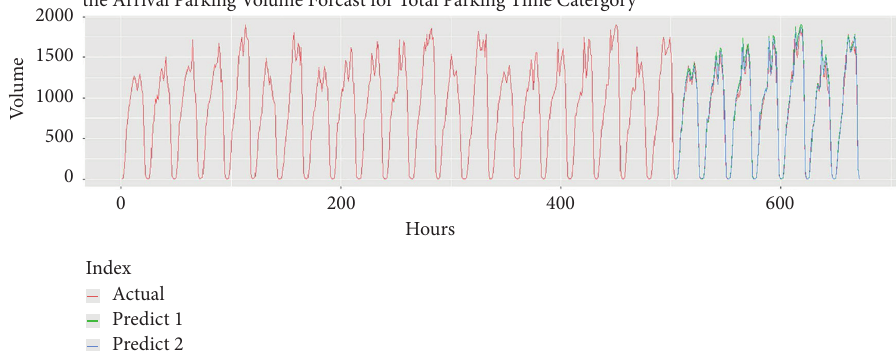
Figure 6: Comparisons of the forecast result of the parking duration with grouping and without